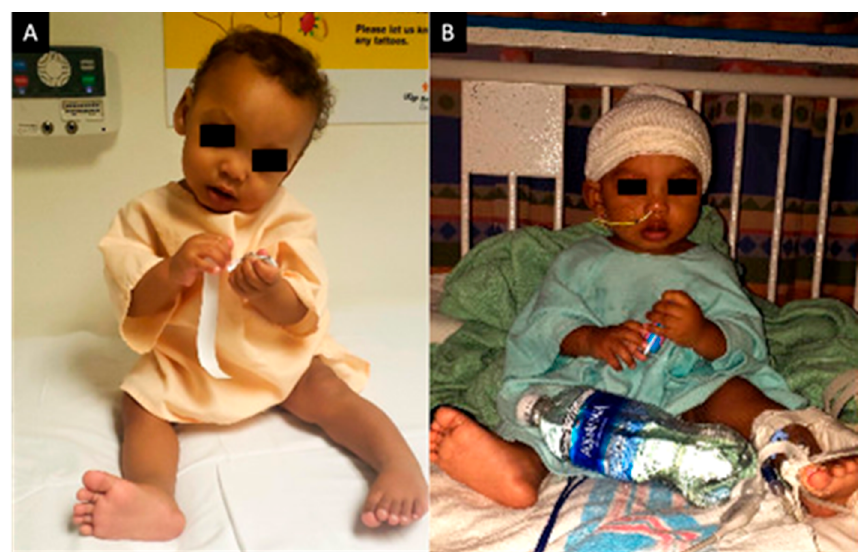
Figure 3. An 8-month-old male infant with torticollis. Panel ( A ) shows the preoperative patient with asymmetric leftward neck flexion and rotation and rightward chin tilt. Panel ( B ) shows the postoperative patient on POD 1 with resolution of prior head/neck flexion and chin tilt, as the neck is now midline. POD = postoperative day.